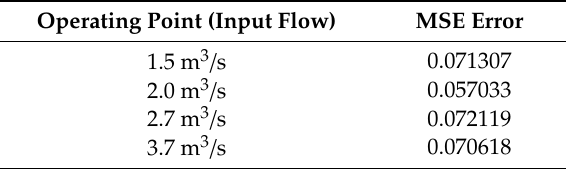
Table 3. Mean square error (MSE) between the observed values (real data) and the estimated values (simulated